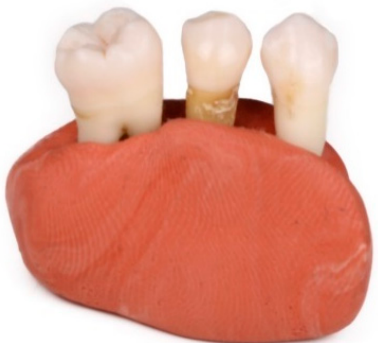
Figure 1. Extracted teeth placed in a silicone socket.